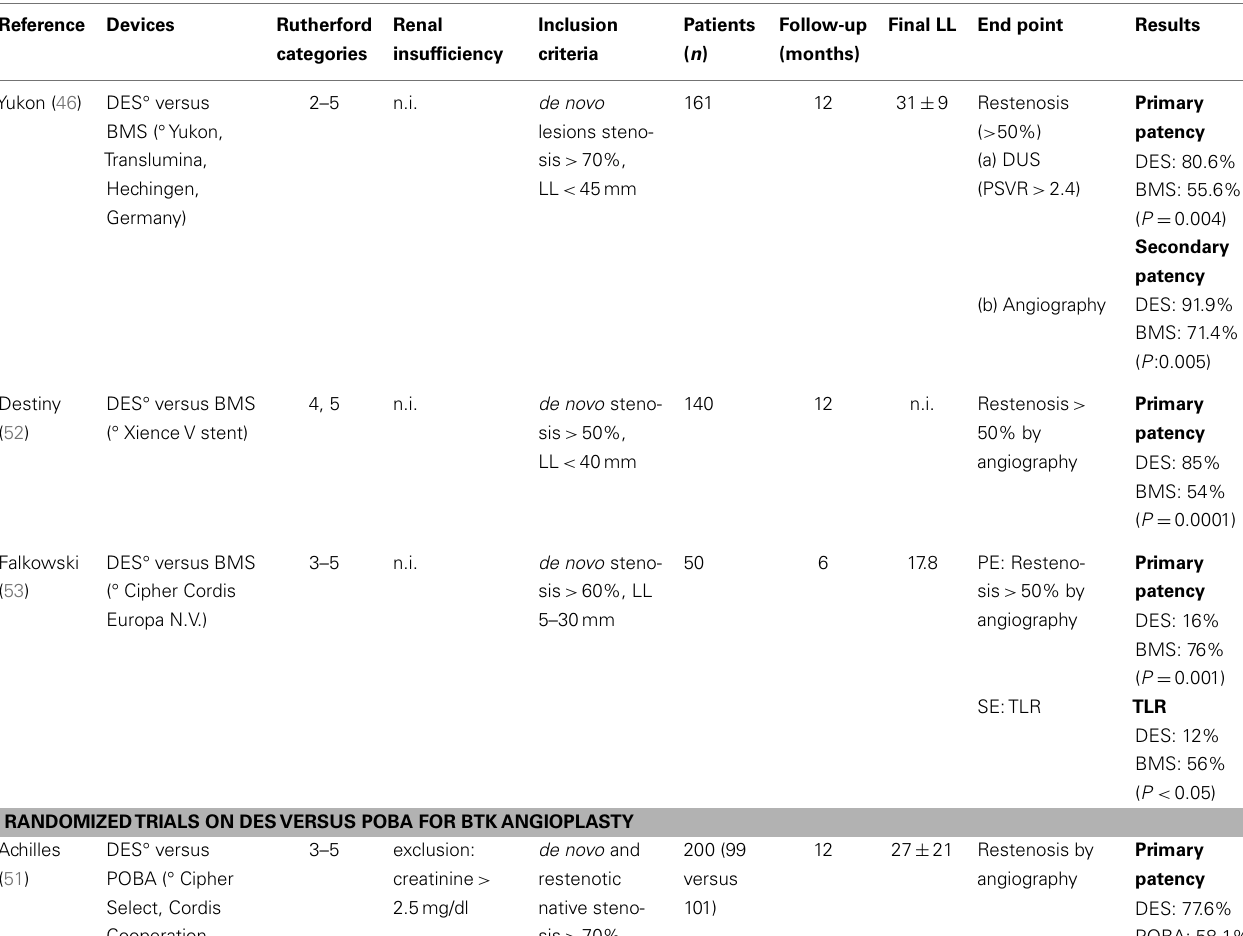
Table 3 | Overview of randomized trials comparing DES versus BMS or POBA for BTK angioplasty . Reference